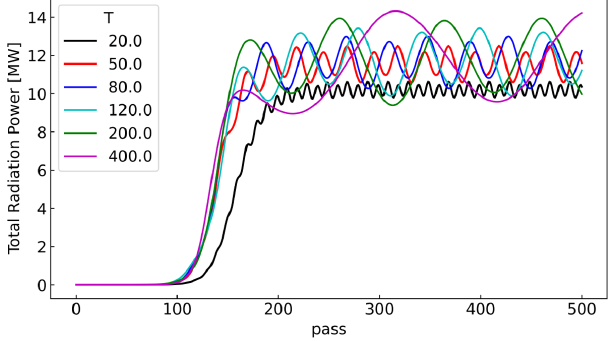
FIG. 7. Evolution of total radiation power per pass for periodic misalignment with the crystal tilt modeled as a sinusoid given by δθ ð t Þ ¼ δθ cos ð ω t Þ for six different frequencies in XFELO-A. The label T indicates the period in turns associated with each